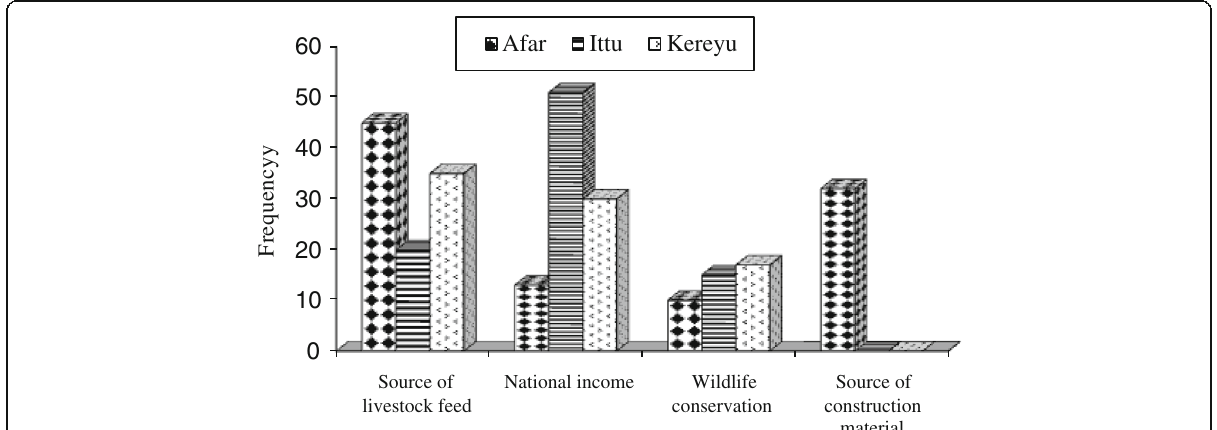
Fig. 3 Response of households between three ethnic groups (Afar, Ittu, and Kereyu) about the distribution of assumed benefits around Awash National Park, Ethiopia ( n =